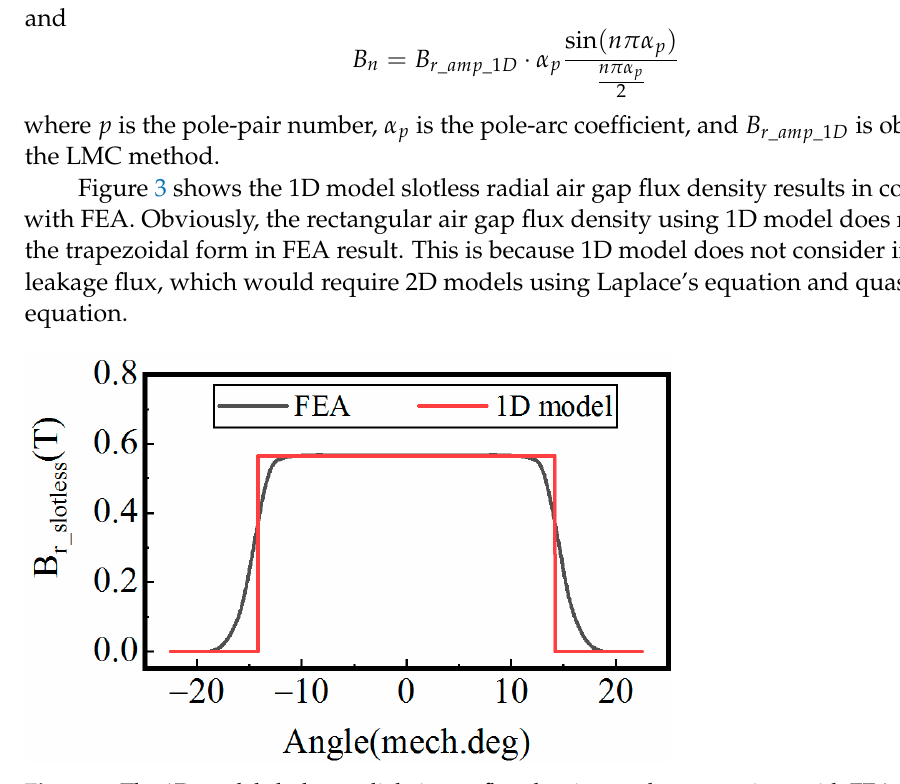
Figure 3. The 1D model slotless radial air gap flux density results comparison with